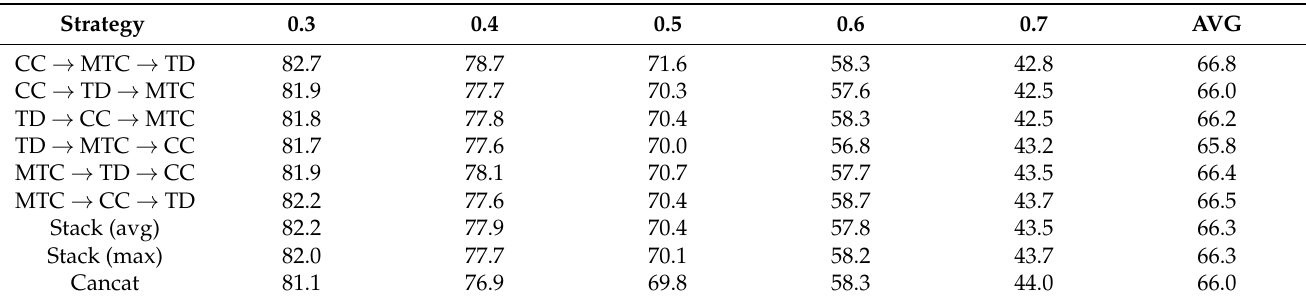
Table 6. Ablation Study (impact of combination strategies). Comparing the effects of different com- bined strategies, measured by mAP@tIoU at different thresholds and the average mAP (mAP@avg)